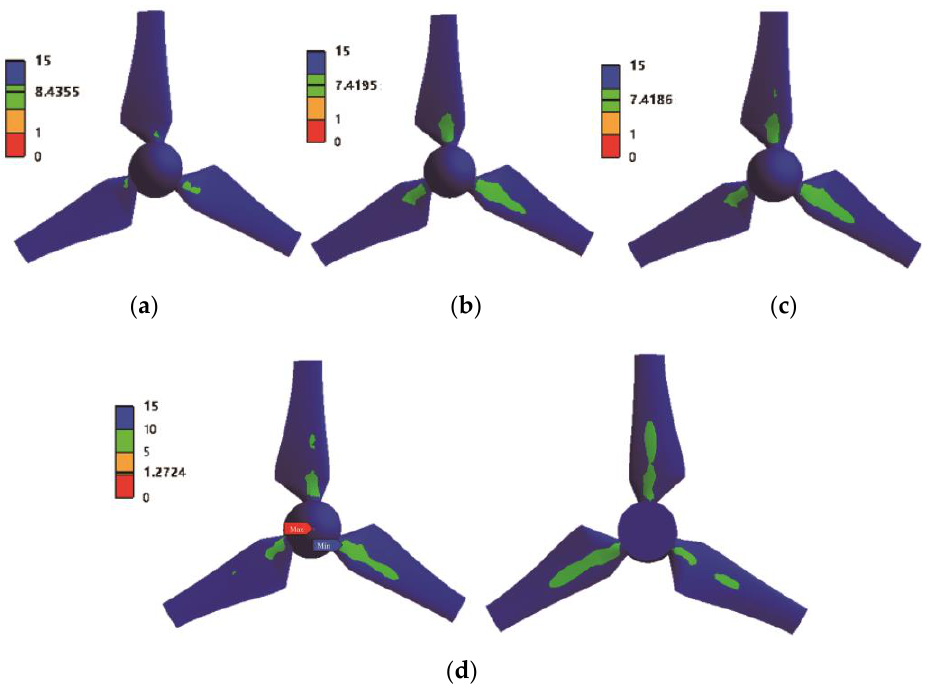
Figure 14. Blade safety factor at different rotational speeds: ( a ) 92.69 r/min, ( b ) 100 r/min, ( c ) 102.11 r/min, and ( d ) 110.01 r/min. ( c ) 102.11 r/min, and ( d ) 110.01